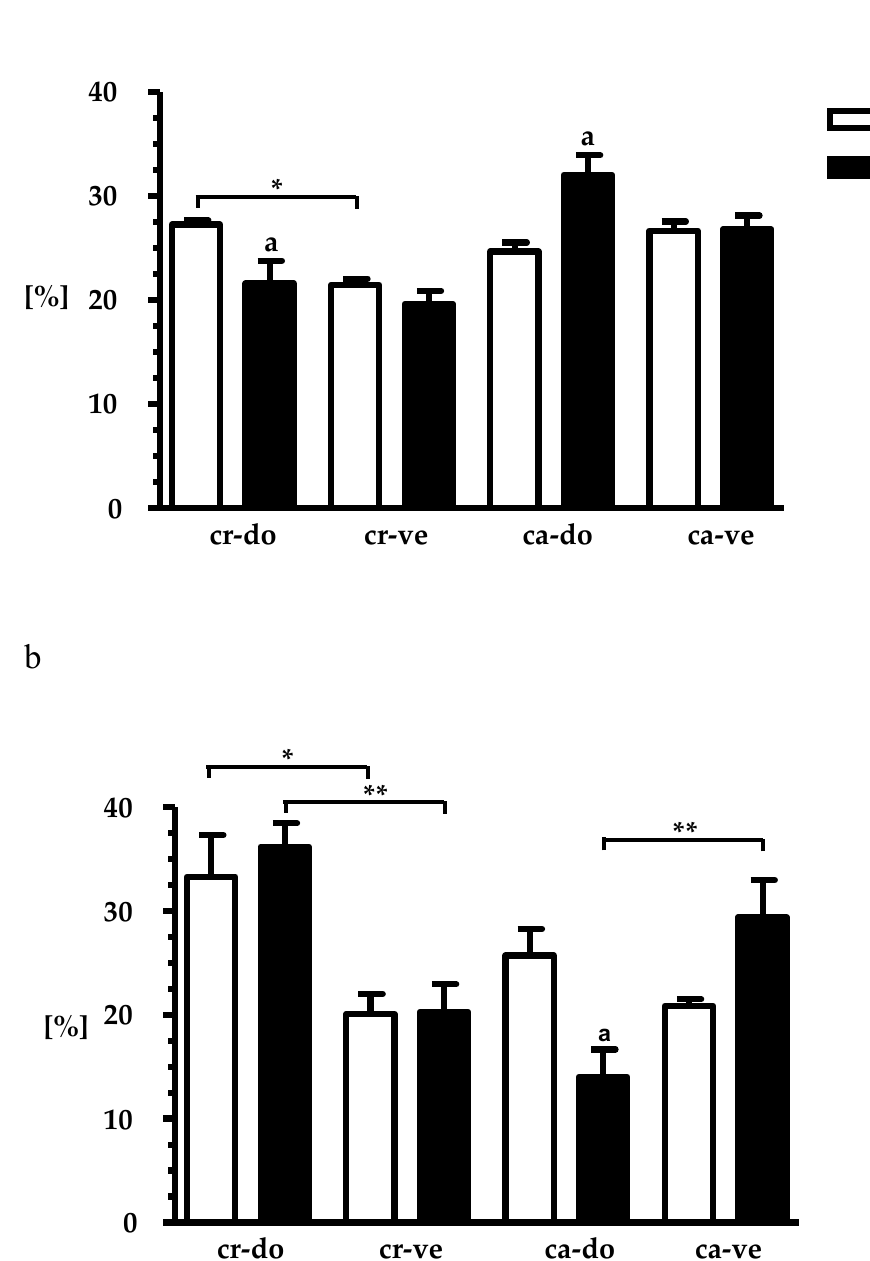
Figure 4. Relative frequency (mean ± SEM; n = 4) of skin-projecting small- and large-diameter neurons in particular subdomains of the lumbar (( a ) L 2 –L 6 ; open bars); and sacral (( b ) S 1 –S 2 ; solid bars) SChGs studied. a Indicates statistically-significant differences ( p < 0.05) between the lumbar and sacral SChGs. * p < 0.05, ** p < 0.01 indicate statistically-significant differences between the cranio-dorsal (cr-do) and cranio-ventral (cr-ve) or caudo-dorsal (ca-do) and caudo-ventral (ca-ve) subdomains of lumbar and sacral SChGs.